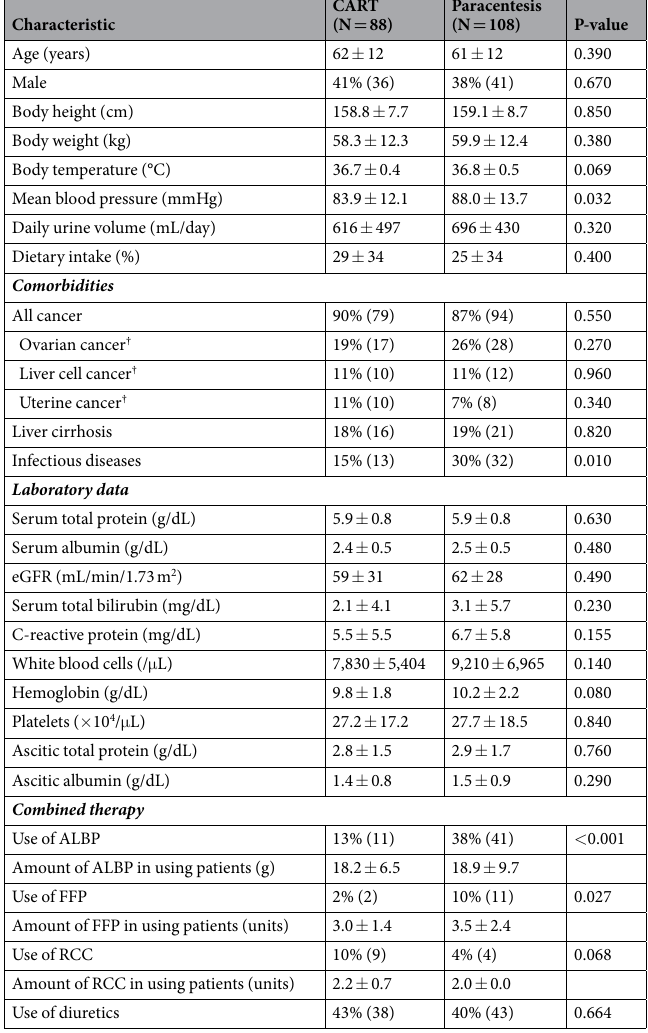
Table 1. Characteristics of studied patients and combined transfusion therapy. † Top 3 types among all cancers in this cohort. Qualitative data, percentage (number); P-values were calculated by the chi-square test. Quantitative data, mean ± SD; P-values were calculated by the Student t